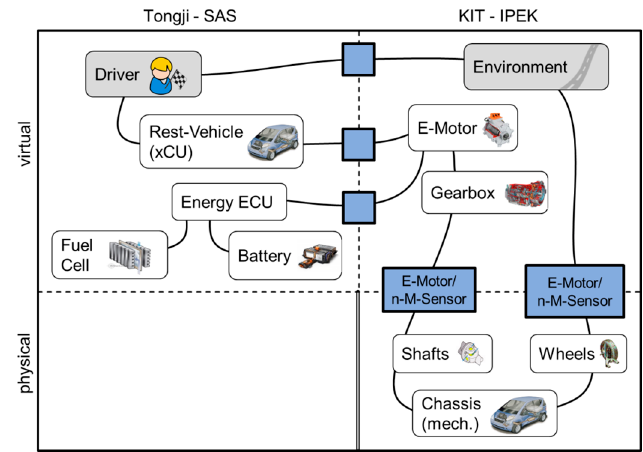
Figure 2. Data flow of distributed test platform aimed at transparency research.